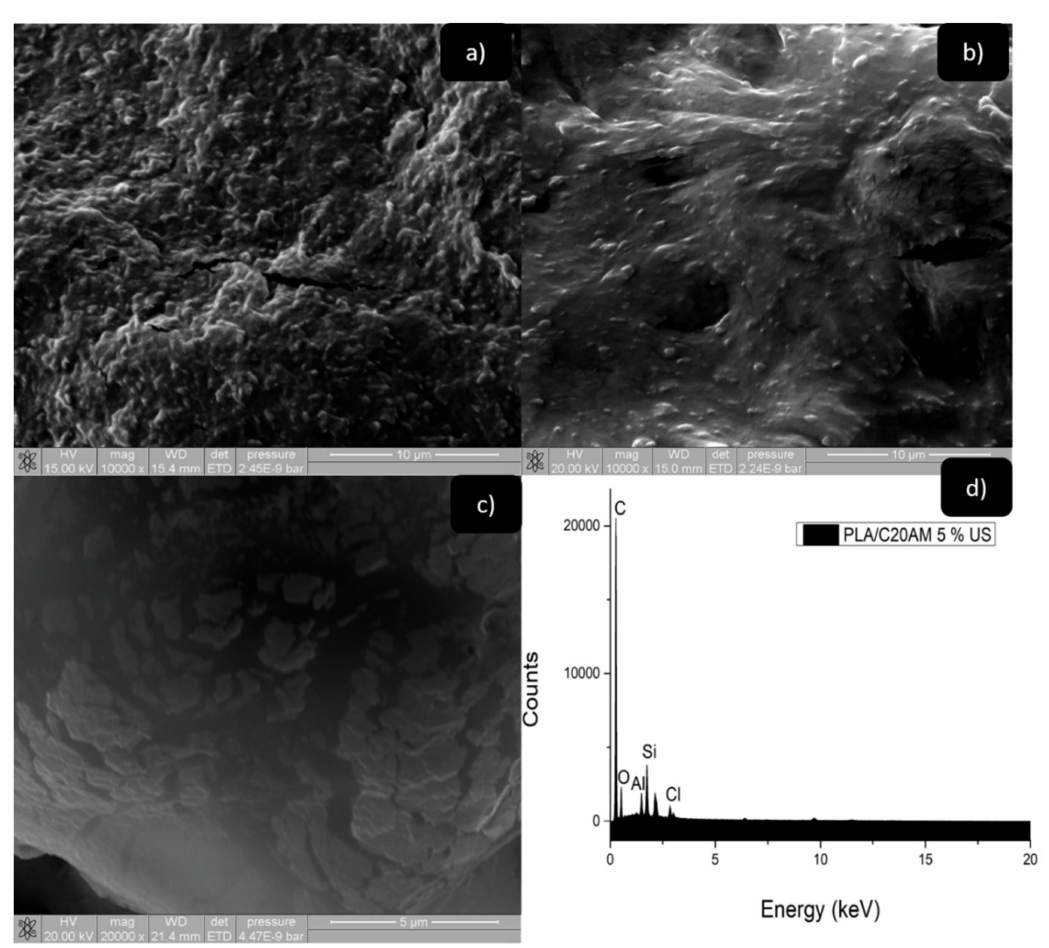
Figure 10. SEM images of nanocomposite ( a ) PLA/C20AM 1% at 10,000 × , ( b ) PLA/C20AM 5% at 10,000 × , ( c ) PLA/C20AM 5% at 20,000 × and ( d ) EDS PLA/C20AM